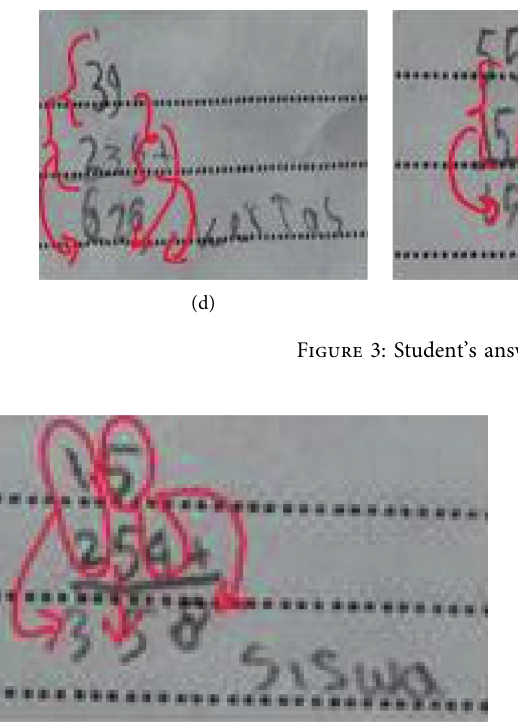
Figure 4: Answer of the student who does not understand the place value in short-complex